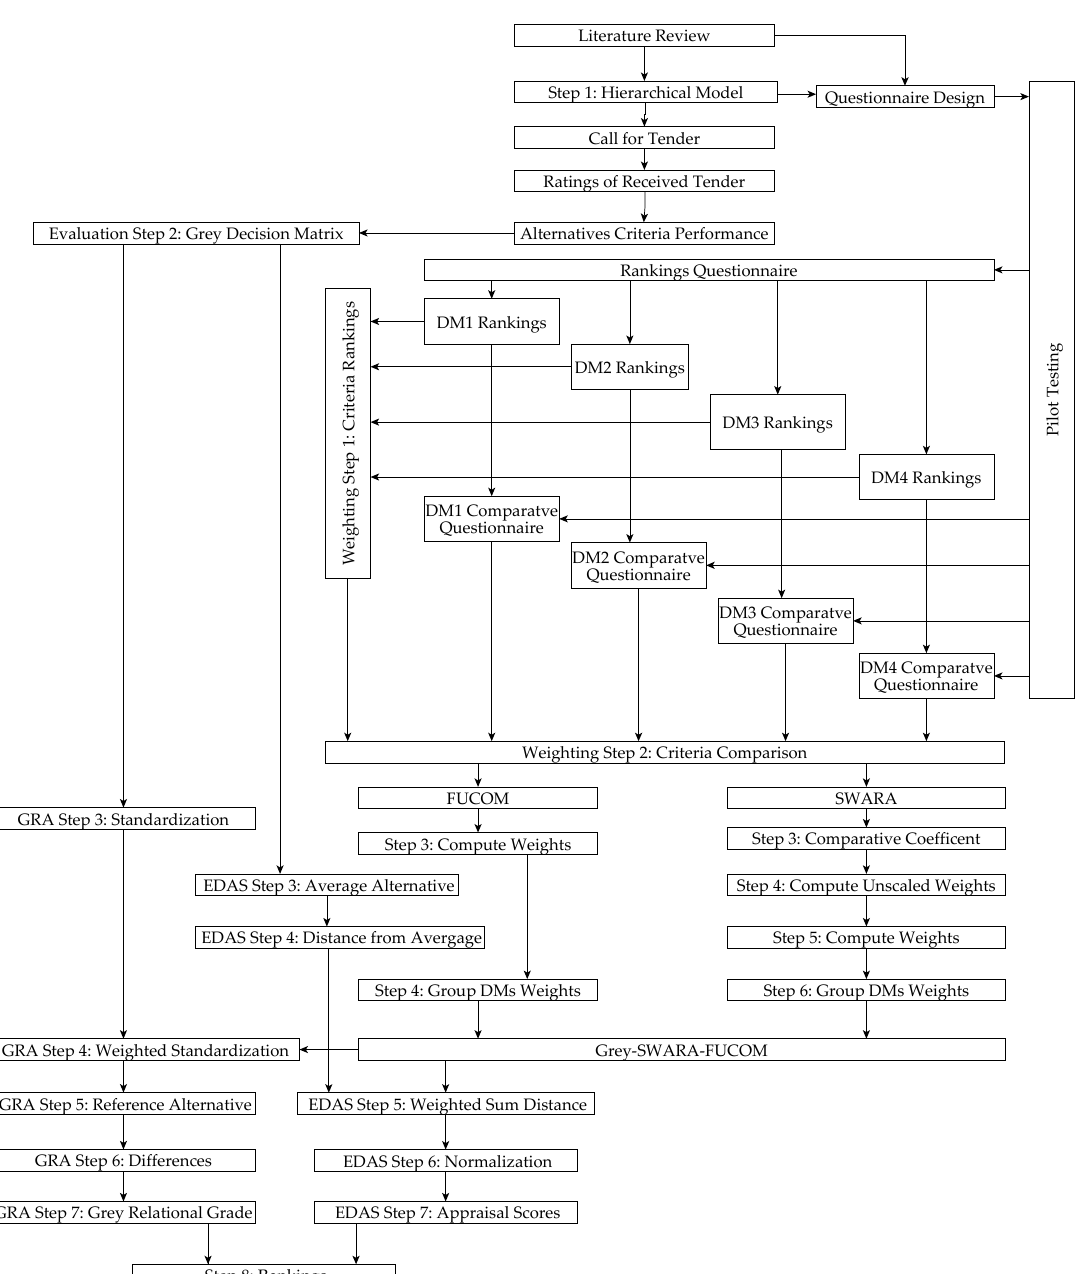
Figure 2. Evaluation process using the grey stepwise weight analysis ratio assessment-full consistent method (SWARA-FUCOM) with grey relational analysis (GRA) and evaluation based on distance from average solution (EDAS).